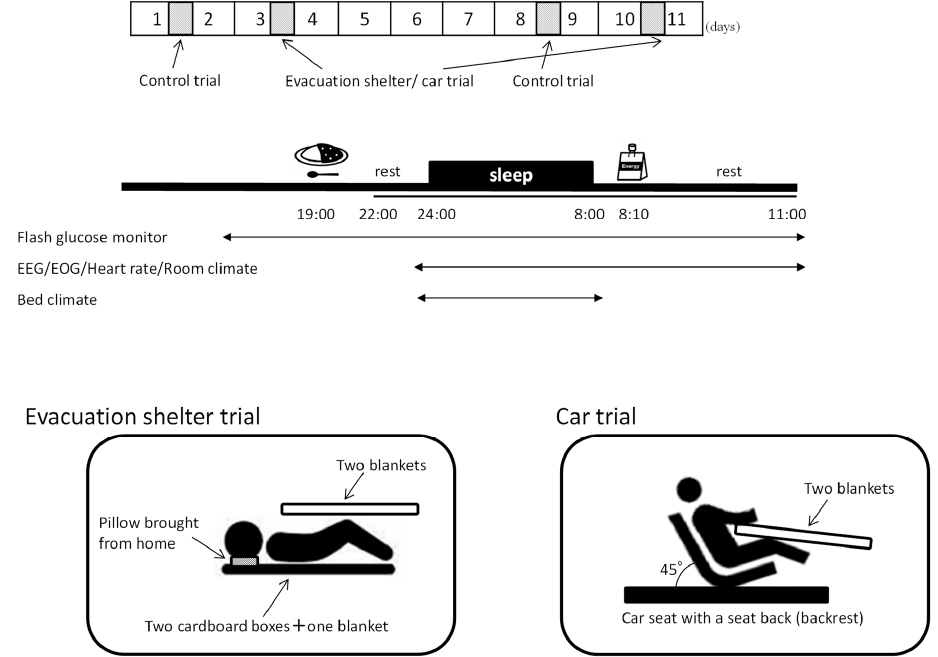
Figure 1. Study protocol: schematic overview of the study protocol ( top ); time schedule of